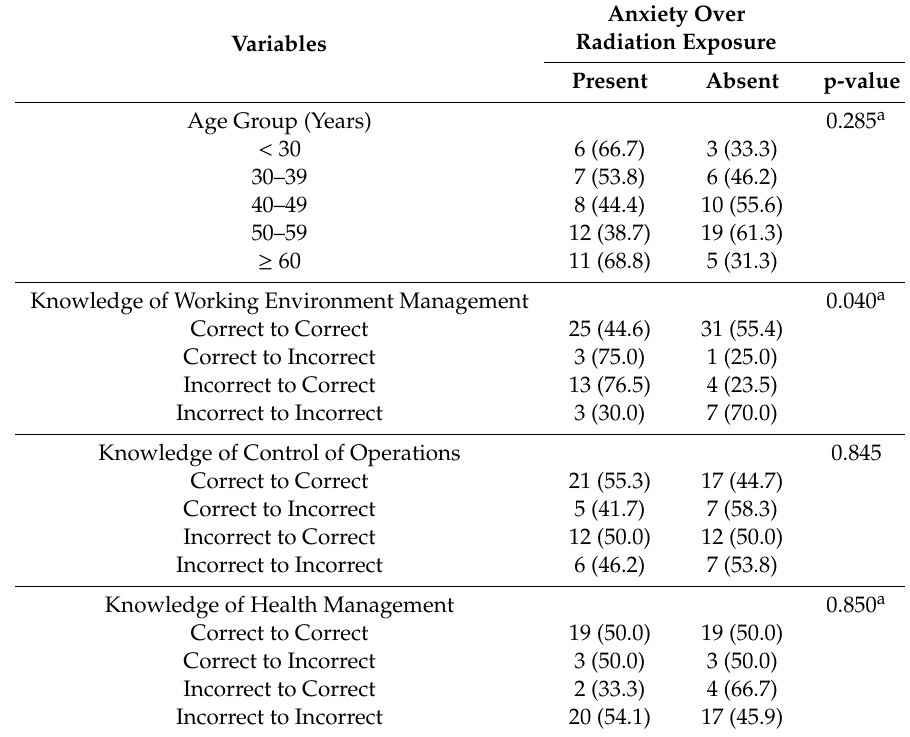
Table 3. Associations of anxiety over radiation exposure after training session with age and answer patterns.